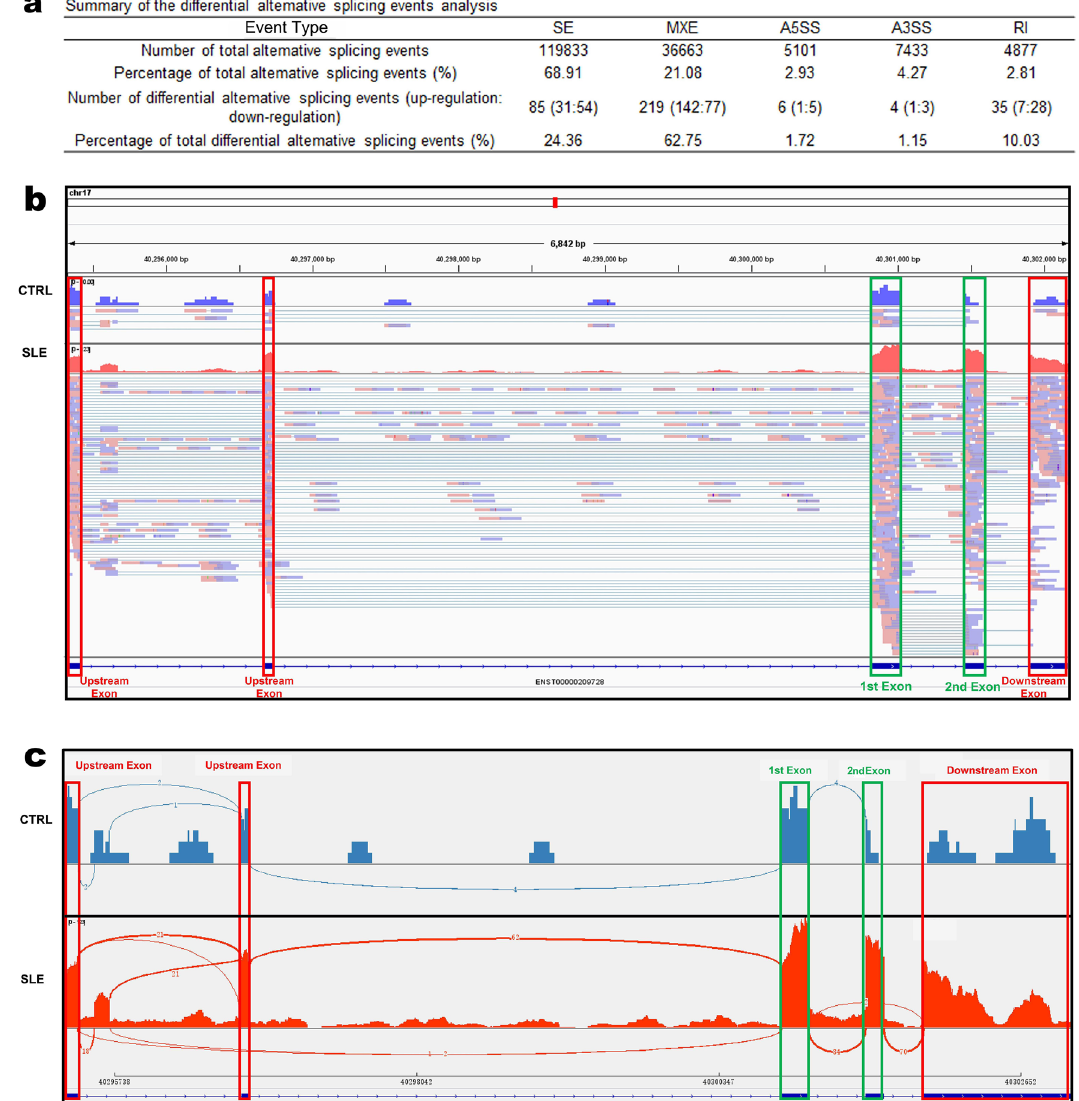
Figure 6. Differential alternative splicing events. (a) Summary of the differential alternative splicing event analysis results. (b) Read distribution plot of cell division cycle 6 ( CDC6 ) with differential isoform expressions due to mutual exclusive exon (MXE). The histograms represent the abundance of the reads (blue represents CTRL1, red represents SLE19). Reads track, which directly displays the comparison of reads, is shown below the histograms. The green boxes represent the 1st exon or the 2nd exon where MXE occurs. (c) Sashimi plot is taken from the IGV Viewer that shows an MXE of the gene CDC6 that occurred in CTRL1 and SLE19. All of the splice junctions detected were labeled, and the numbers on the arc represent the read depths of the